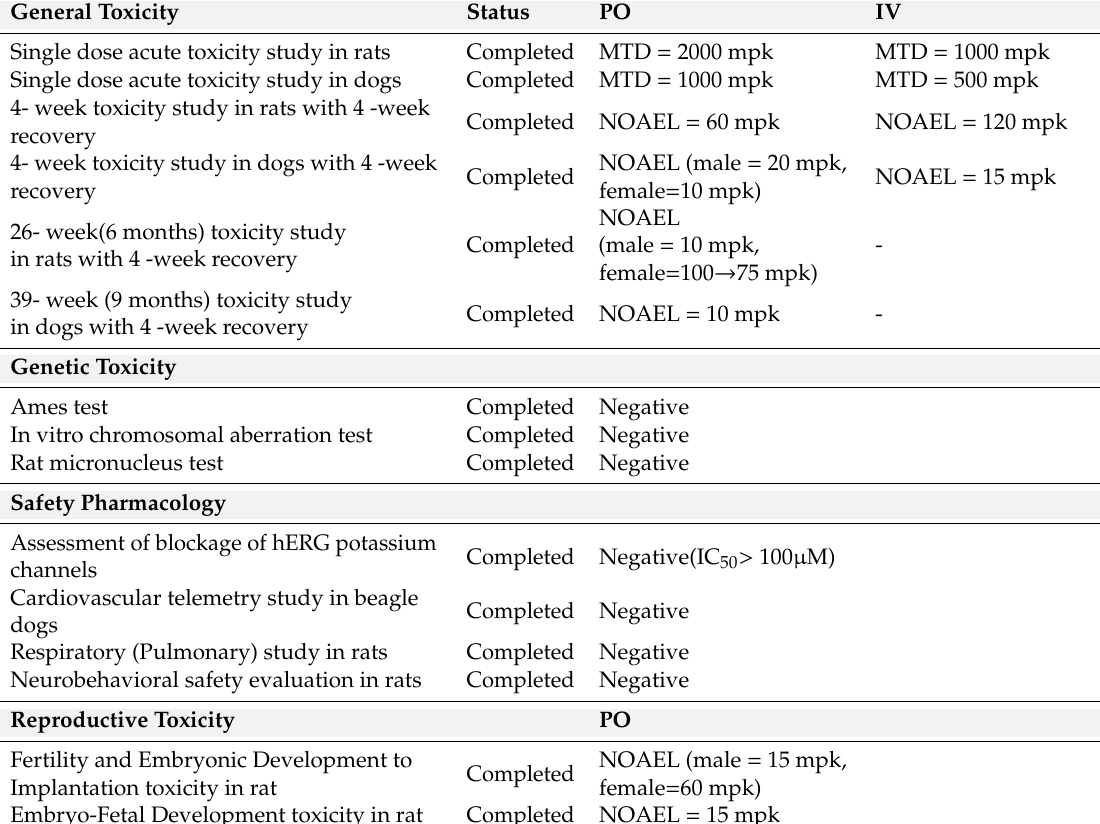
Table 3. Toxicology summary (PO: per oral / IV: intravenous). The general toxicity of delpazolid in animals lasted up to six months in rats and nine months in dogs, and no unusual findings after long-term treatment a